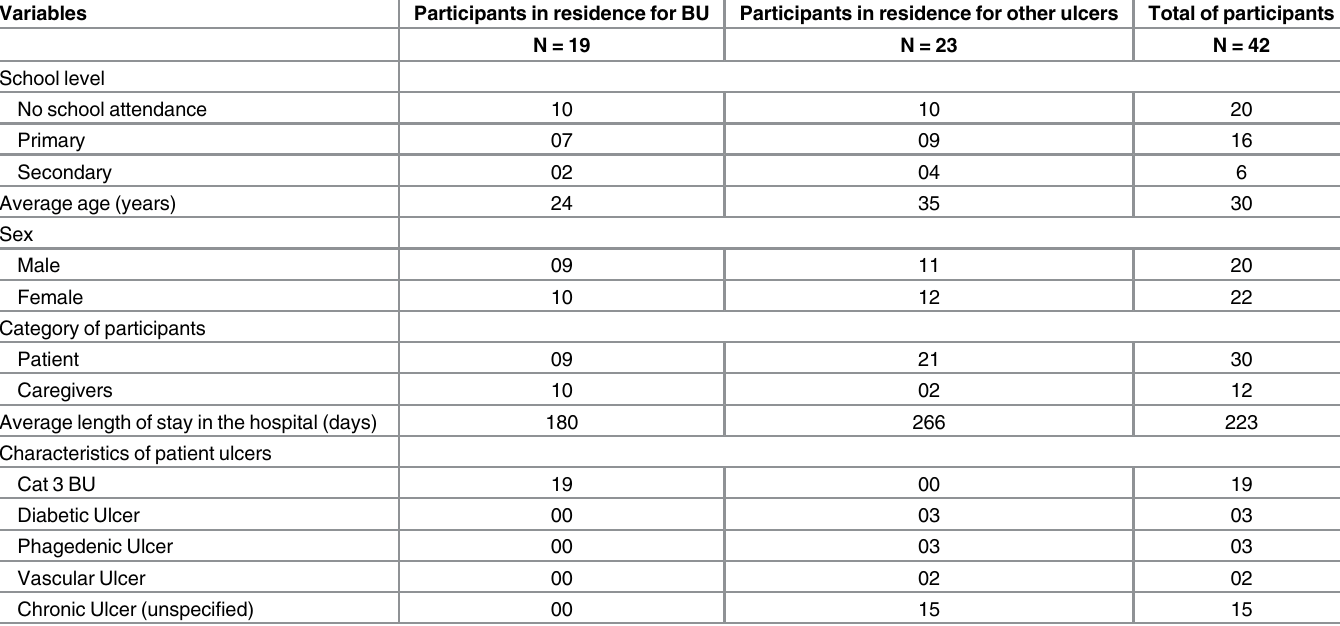
Table 1. Demographic and clinical characteristics of participants in initial qualitative